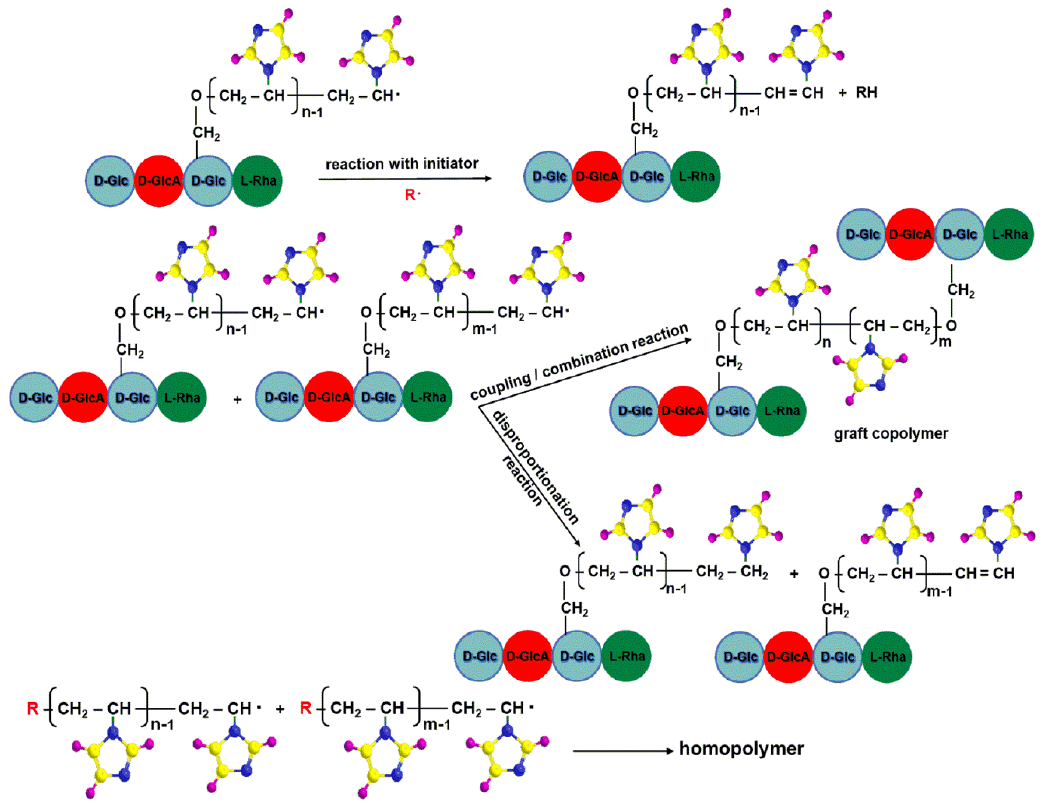
Figure 7. Termination steps of graft copolymerization.